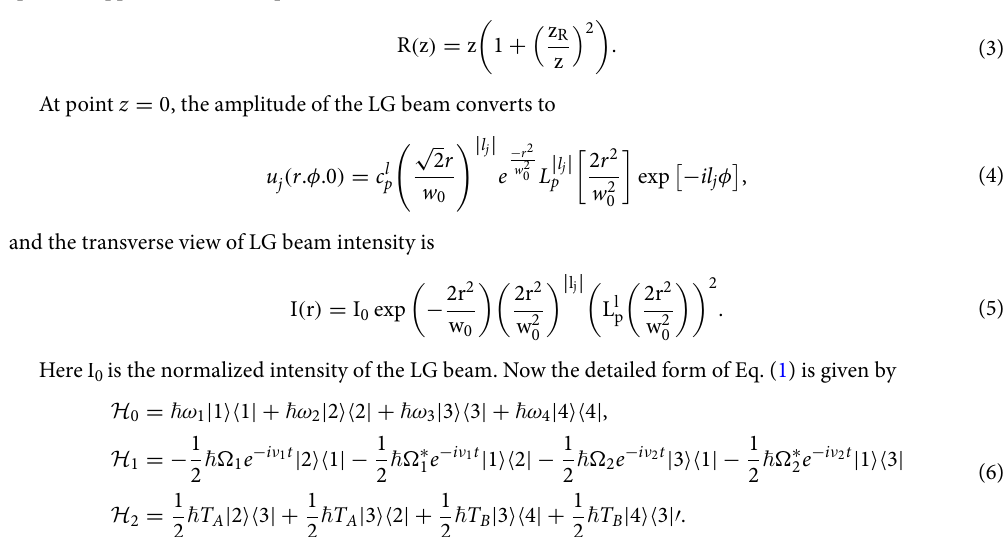
i , and � 1 (� 2 ) represent the Rabi-frequency between levels | �